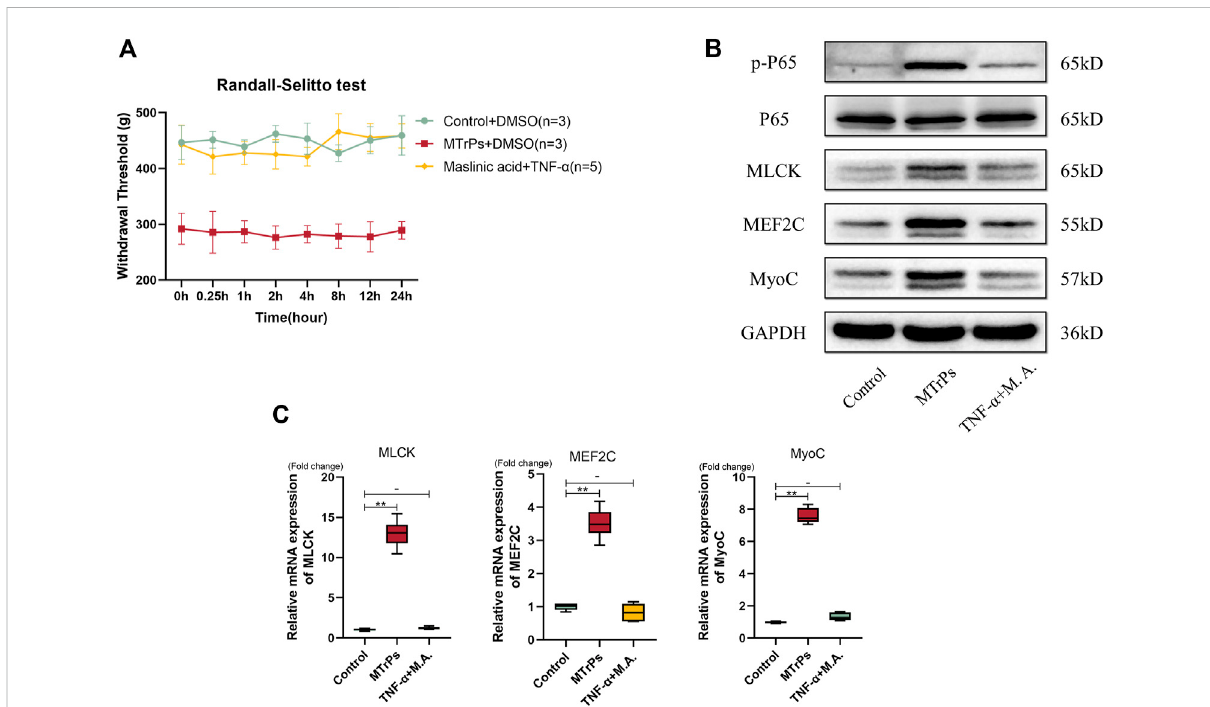
FIGURE 5 (A) The changes in mechanical pressure pain thresholds in the Control group of rats injected with Maslinic acid (5 mg/ml) 1 h in advance followed by TNF- α (0.1 mg/ml) were not statistically different from the control group. (B) . The expression of p-P65, P65, MLCK, MEF2C, and MyoC was detected 2 h after injection of M.A. and TNF- α . There was no statistical difference in expression levels between the two groups. (C) . The mRNA expression levels of MLCK, MEF2C, and MyoC in the M.A. and TNF- α injection groups were not signi fi cantly different, and GAPDH was used as the internal reference mRNA. * p < 0.05, ** p <